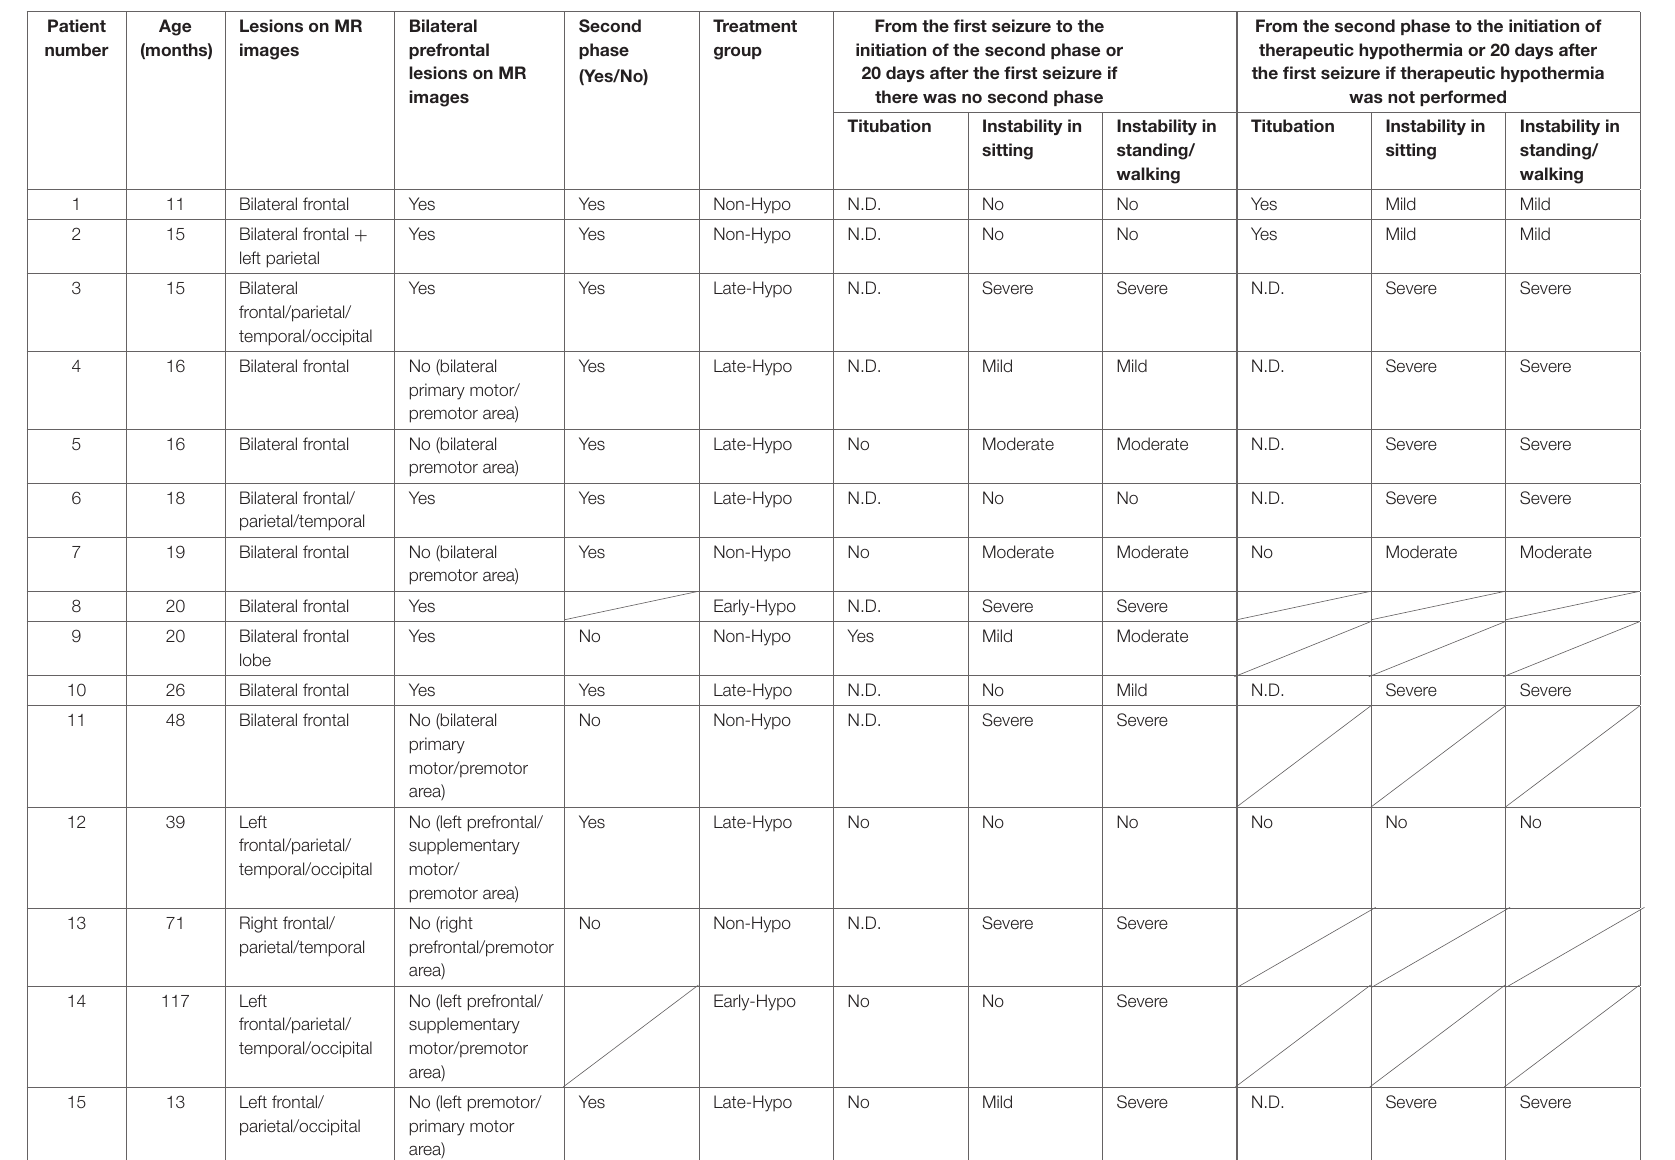
TABLE 1 | Clinical characteristics of the